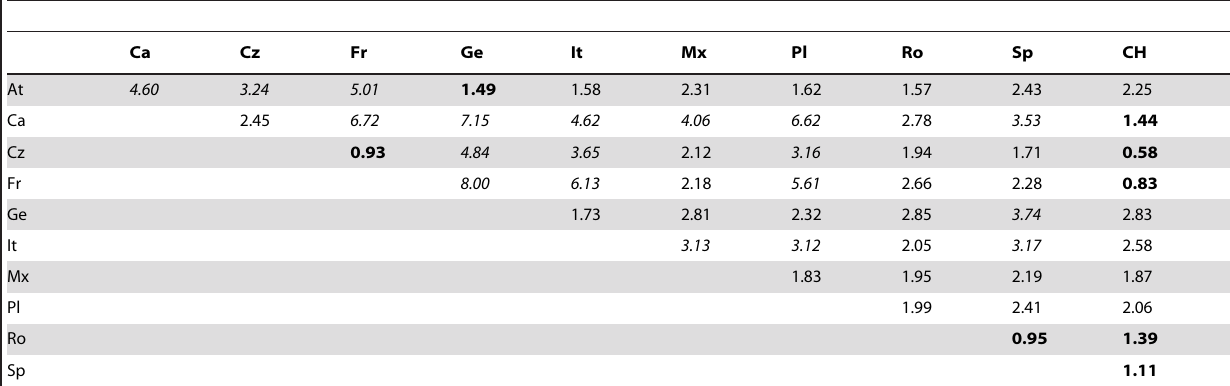
Table 2. Kolmogorov-Smirnov distance, d KS , between the ‘‘super-distributions’’ corresponding to different countries.